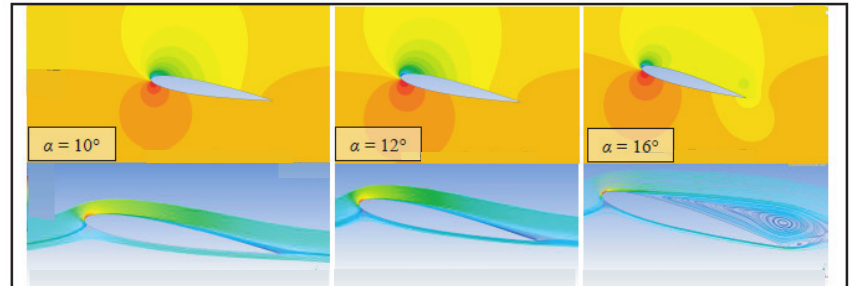
Figure 28. Pressure contours and streamlines at Re = 3.6 × 10 5 .